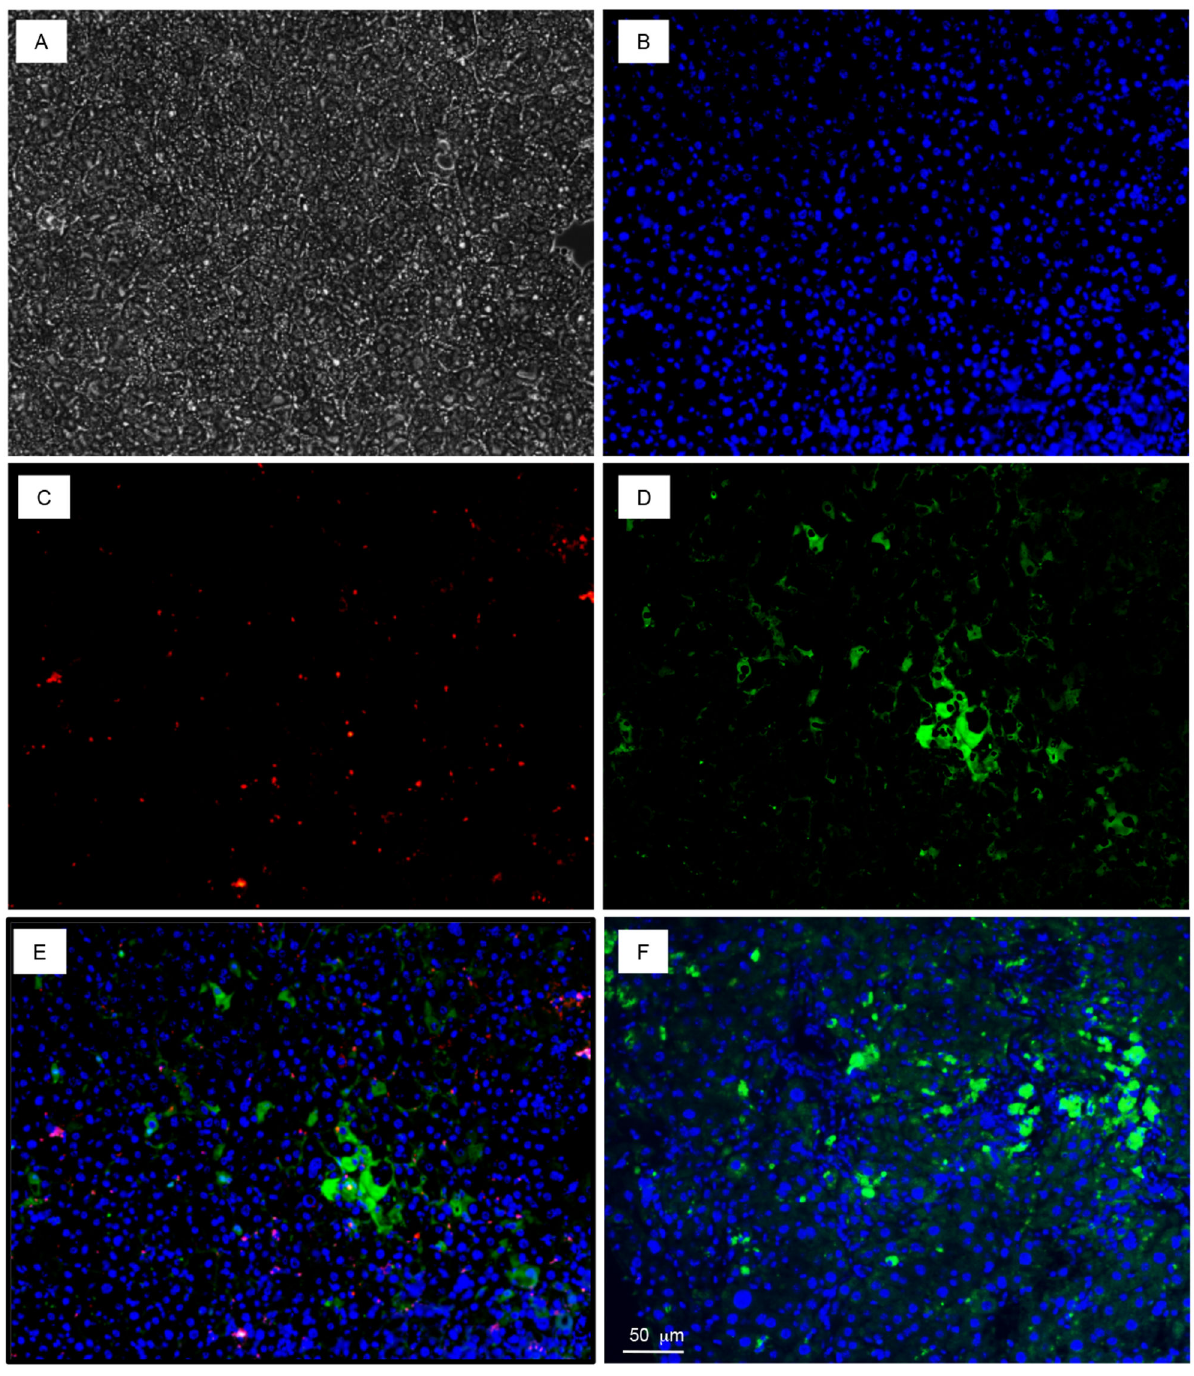
Figure 10. Detection of HCV infection in transgenic MUP-uPA/SCID/Bg mice engrafted with human hepatocytes. A . .Bright field image of transgenic mouse liver section. B . DAPI staining of nuclei. C . Stained with anti-hAlb (green). D . Stained with anti-HCV (NS5) antibody (red). E . Merged sections that were stained with both anti-hAlb and anti-HCV (NS5) primary antibodies (yellow). F . Section from engrafted but not virus infected mouse liver stained with anti-hAlb and anti-HCV (NS5) primary antibodies.